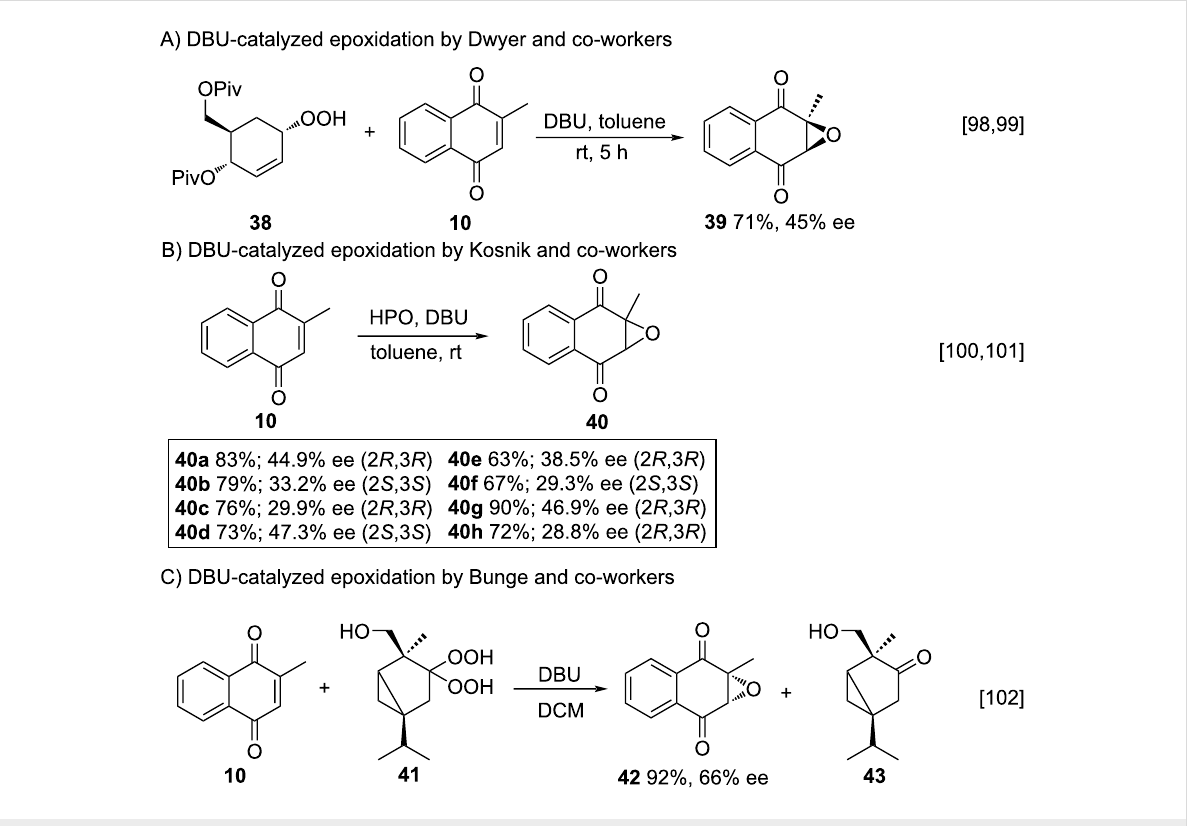
and co-workers described a procedure using sugar-derived hydroperoxides for the synthesis of epoxides in the presence of 1,8-diazabicyclo[5.4.0]undec-7-ene (DBU) as base [98,99]. The authors studied a broad range of quinone derivatives among which compound 39 was obtained through reaction of mena- dione ( 10 ) and hydroperoxide 38 in 71% yield and 45% ee (Scheme 11A). Analogously, Kosnik and co-workers described a similar epoxidation methodology using a series of pyranose- derived anomeric hydroperoxides (HPO) to obtain epoxides 40 with moderate ees (Scheme 11B) [100,101]. Bunge and co-workers used the enantiomerically pure dihydroperoxide 41 in the DBU-mediated epoxidation of menadione ( 10 ) for the enantioselective synthesis of epoxide 42 (92% yield and 45–66% ee) (Scheme 11C)